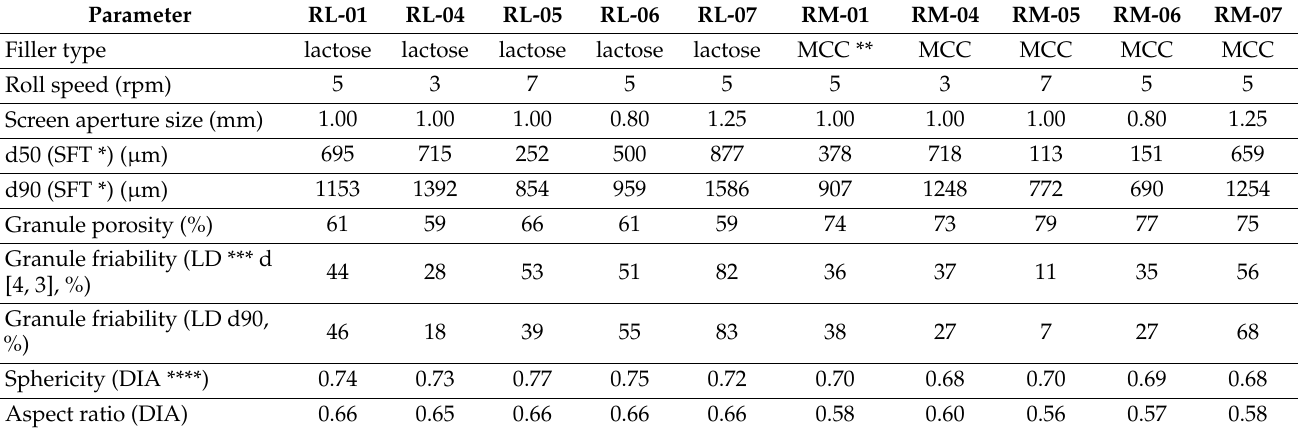
Figure 5. Compressibility plot of selected compression mixtures containing microcrystalline cellu- lose (MCC) as a filler.